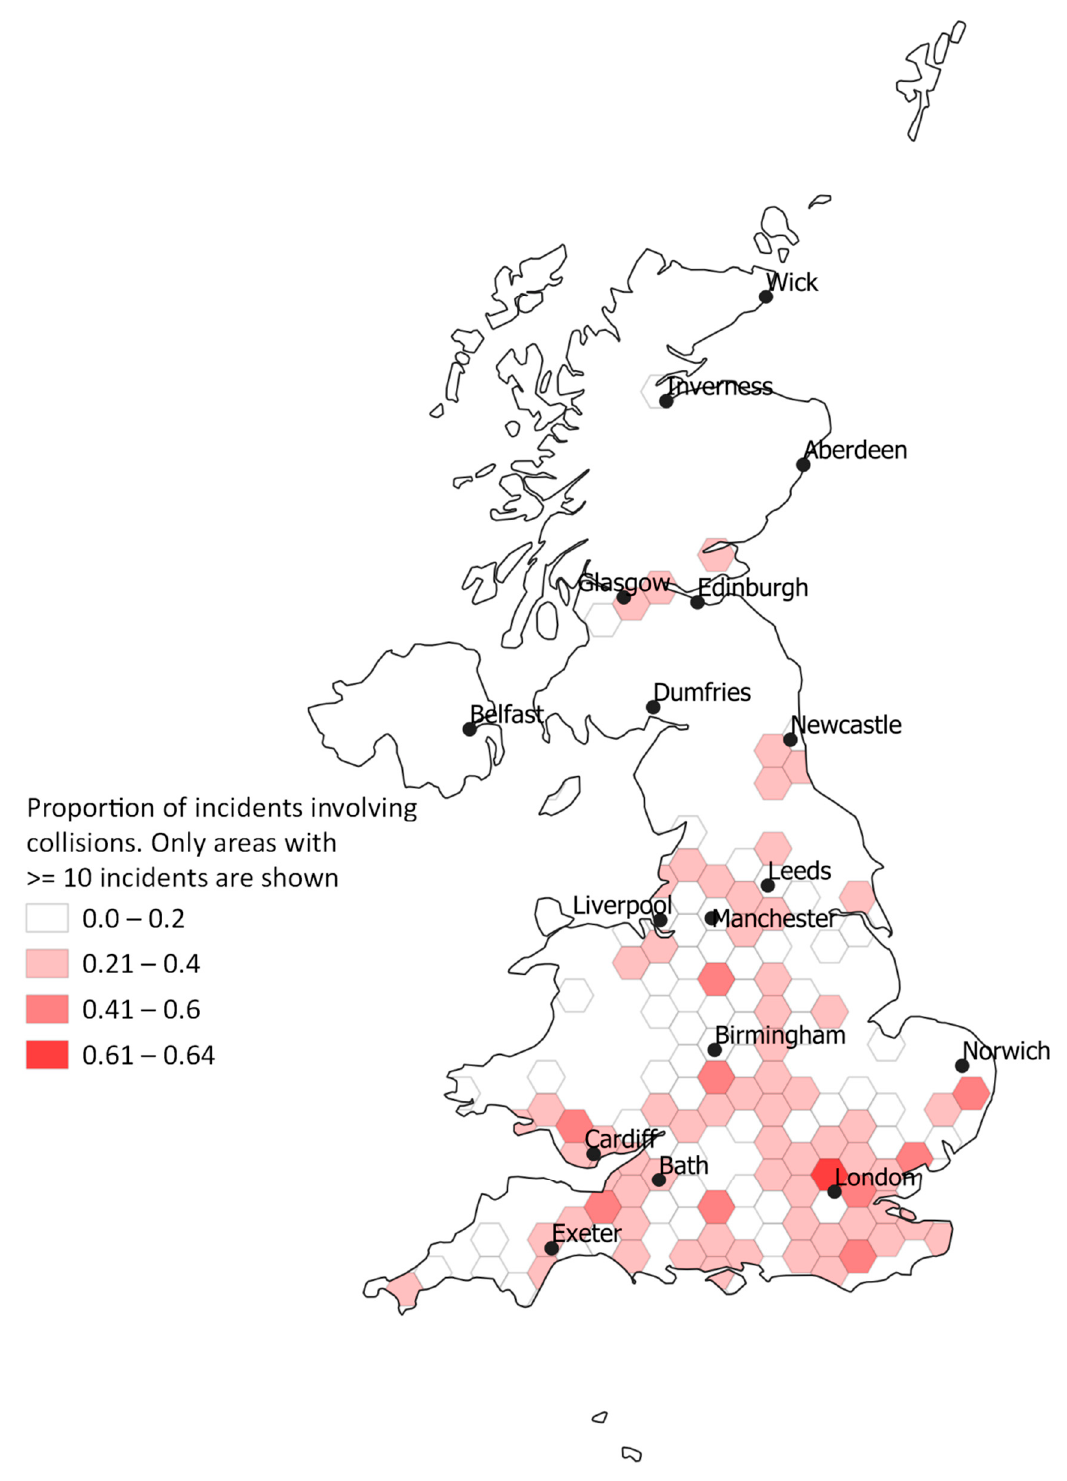
Figure 5. Choropleth map showing the proportion of incidents involving collisions portrayed throughout the United Kingdom where at least 10 incidents per hexagon area took place.